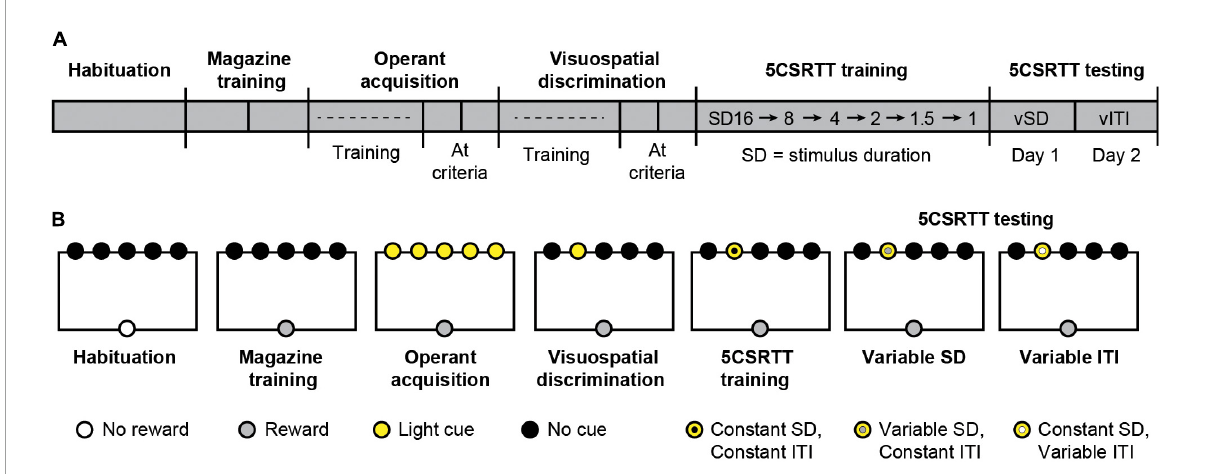
FIGURE1 The five-choice serial reaction time task (5CSRTT) measures attention and impulsivity in mice. (A) Timeline of 5CSRTT. vSD, variable stimulus duration; vITI, variable intertrial interval. (B) Schematic of cues and rewards across all stages of 5CSRTT.